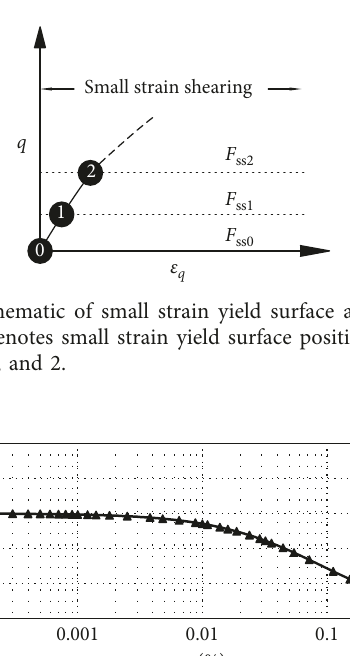
Figure 2: Verification of stress-strain